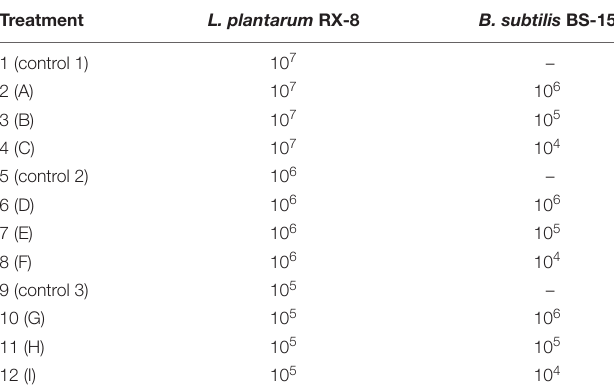
TABLE 1 | Scheme of the inoculation of L. plantarum RX-8 and B. subtilis BS-15 in co-culture systems with different inoculum ratios.